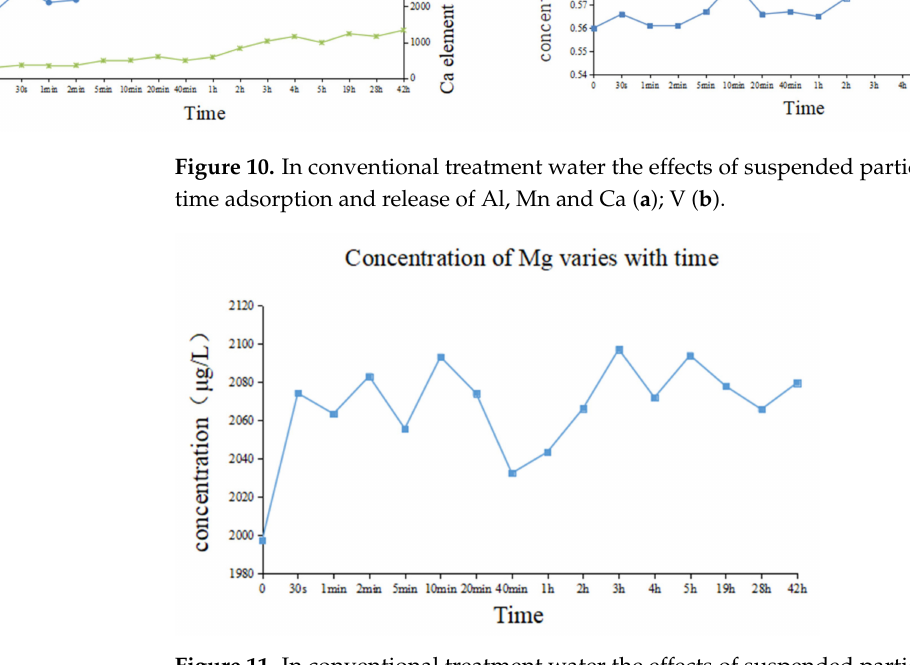
Figure 11. In conventional treatment water the effects of suspended particulate matter at different time adsorption and release of Mg.